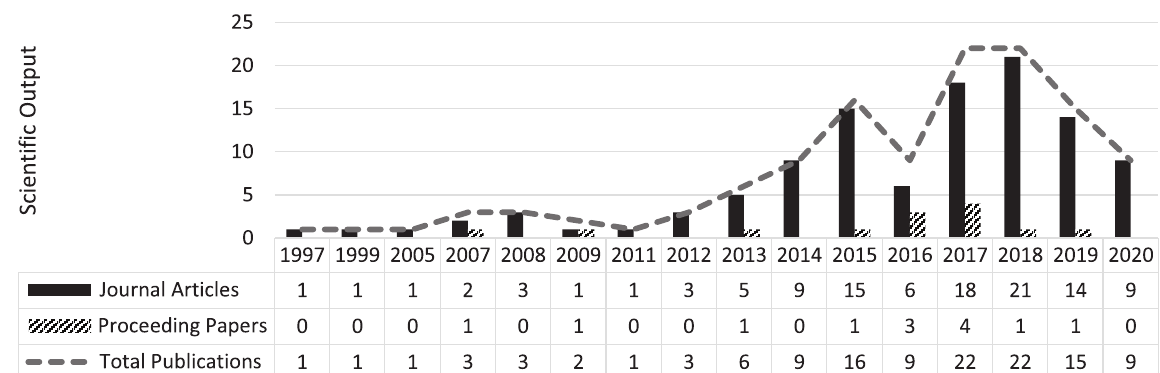
Figure 1. The increase in literature featuring ‘temporary use’ from 1997 until 2020. This visualizes the climbing number of publications per year containing terms from the search query: (“temporary” OR “interim”) AND (“use” OR “urbanism” OR “intervention” OR “design”) AND including (“urban” OR “city” OR “town” OR “metrop*” OR “municipal*”). Years without publications are excluded for visual optimization.